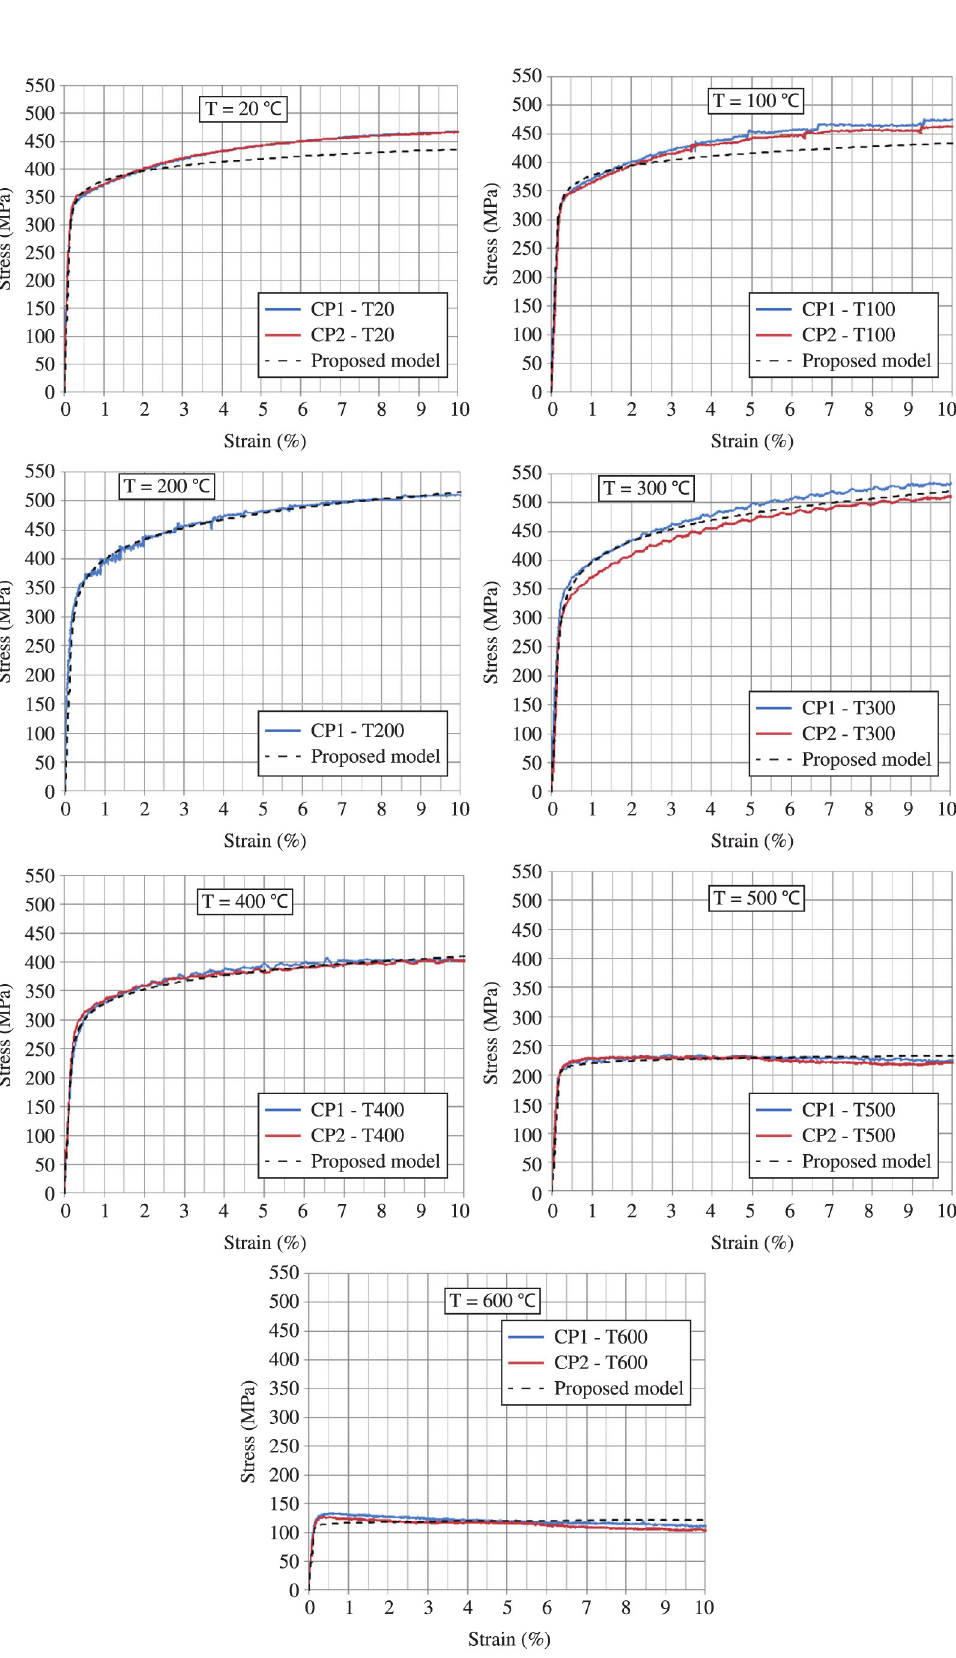
Figure 9. Stress-strain curves for each temperature, according proposed